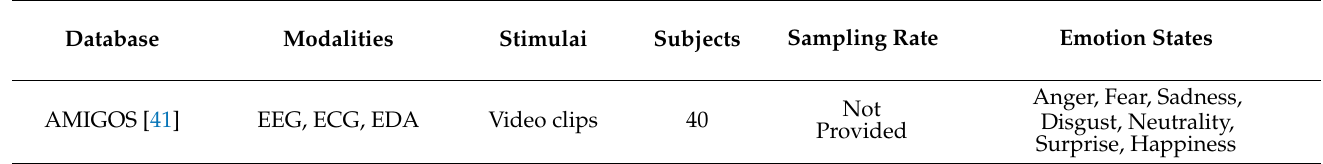
Table 1. Publicly available datasets in alphabetical order for physiological signals-based emotion